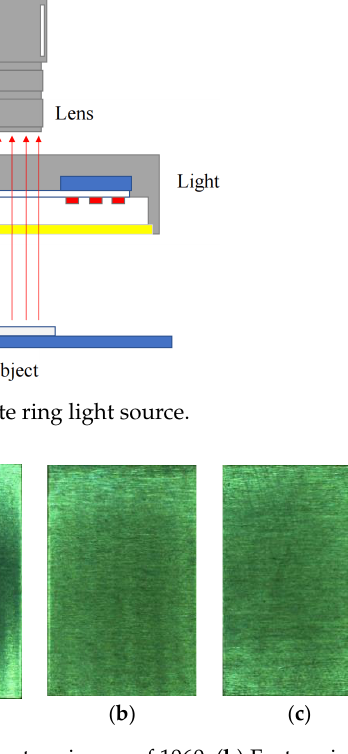
Figure 4. ( a ) Feature image of 1060; ( b ) Feature image of 5052; ( c ) Feature image of 6061.